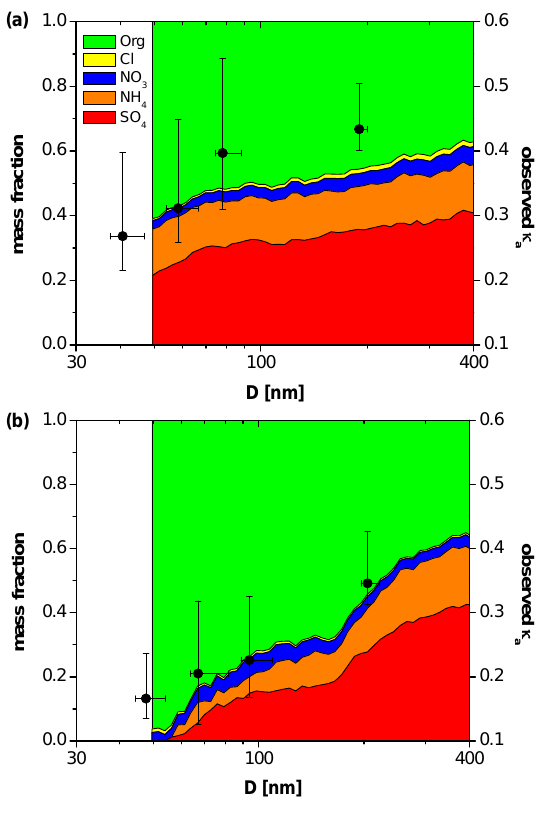
Fig. 2. Size distributions of mass fractions of organic and inor- ganic compounds (colored areas) determined by the AMS, and ob- served effective hygroscopicity parameter of CCN-active particles ( κ a , data points) averaged (a) over the campaign excluding the BBE, and (b) over the BBE. Data points are median values and error bars indicate inter-quartile ranges.